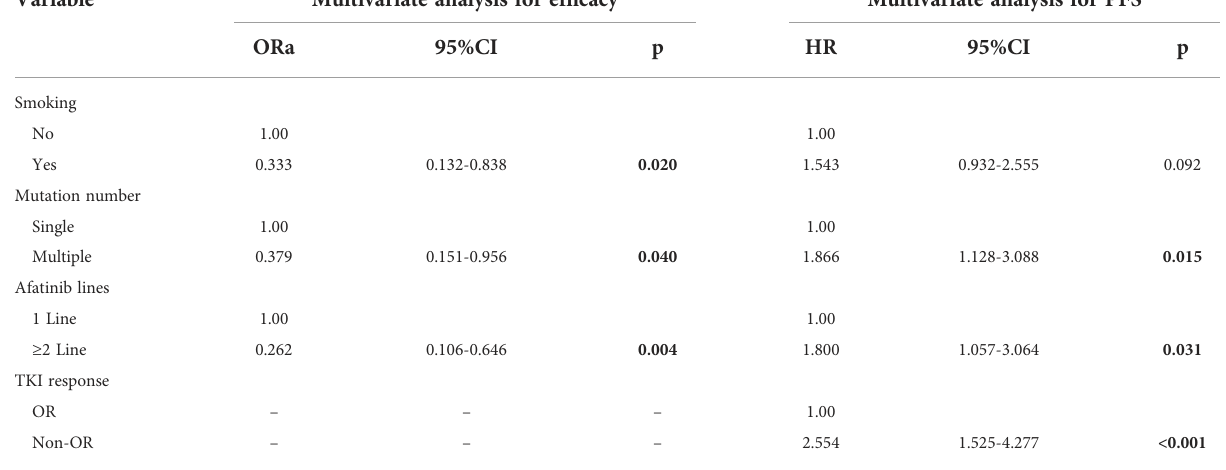
TABLE 2 Multivariate analysis for ef fi cacy and